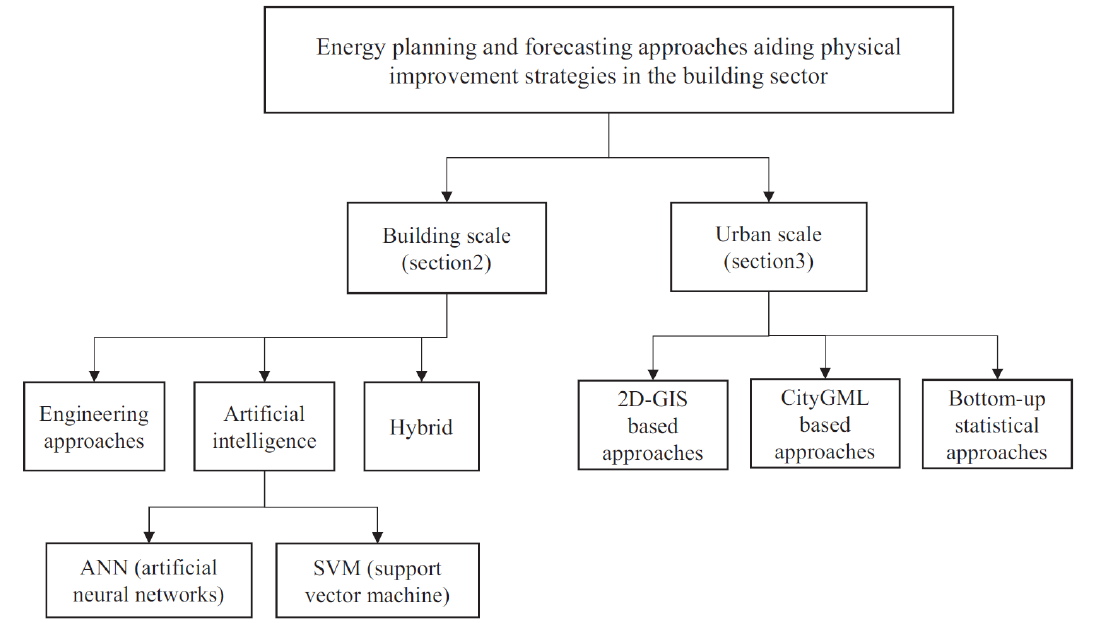
Figure 1. Building energy predictions approach classification